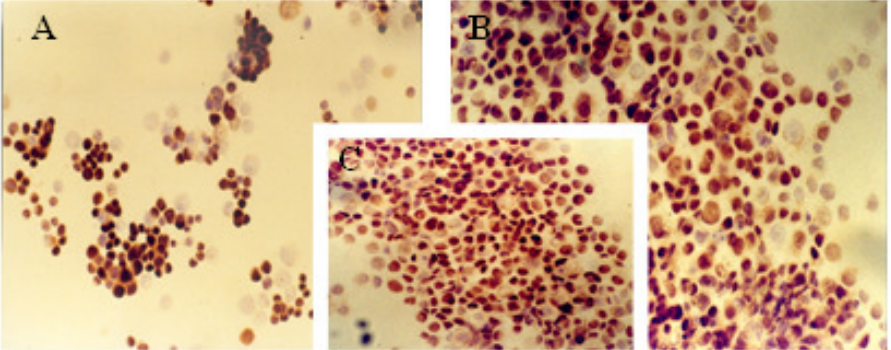
Figure 2. Immunocytochemical study with peroxidase staining of MCF-7 and MCF-7TG cells. Analysis of progesterone receptor (PR) expression in: ( A ) parental MCF-7cells; ( B ) and ( C ) MCF-7TG cells induced with dexamethasone (1 mM) for 2 and 6 days, respectively. (A, C, X 200 magnification; B X 400 magnification).